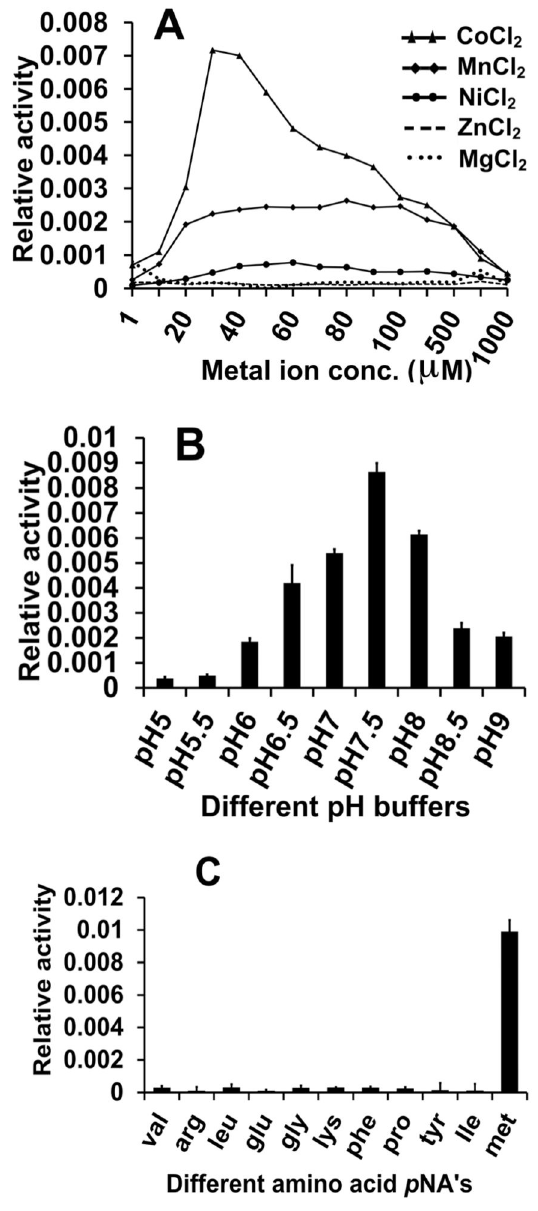
Figure 2. Biochemical characterization of Sp MetAP1a. a) Enzyme binding curve of the Met-pNA at varied concentrations is depicted with the fit value of 0.97924. b) Metal dependency on the activity of the enzyme is tested using five different metal salts ranging from 1-1000 µM. Cobalt is identified as the best co-factor followed by manganese. In the presence of nickel, negligible activity was observed. Zinc and magnesium did not activate the enzyme. c) Activity dependency of the Sp MetAP1a on pH change. Maximum activity was observed at pH 7.5. d) Substrate specificity of the Sp MetAP1a. Among the eleven amino acid- p NA substrates tested, only methionine was hydrolyzed.